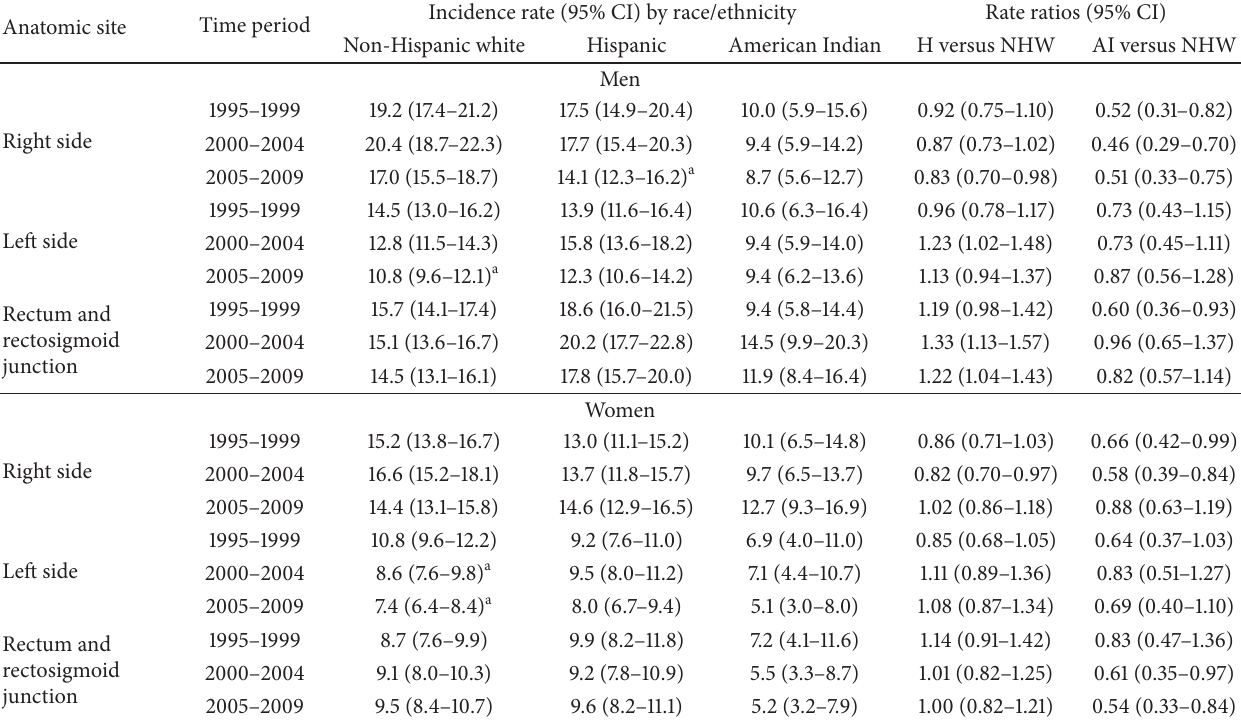
Table 3: Average age-adjusted colorectal cancer incidence rates by anatomic site, time period, gender, and race/ethnicity; New Mexico, 1995– 2009. Anatomic